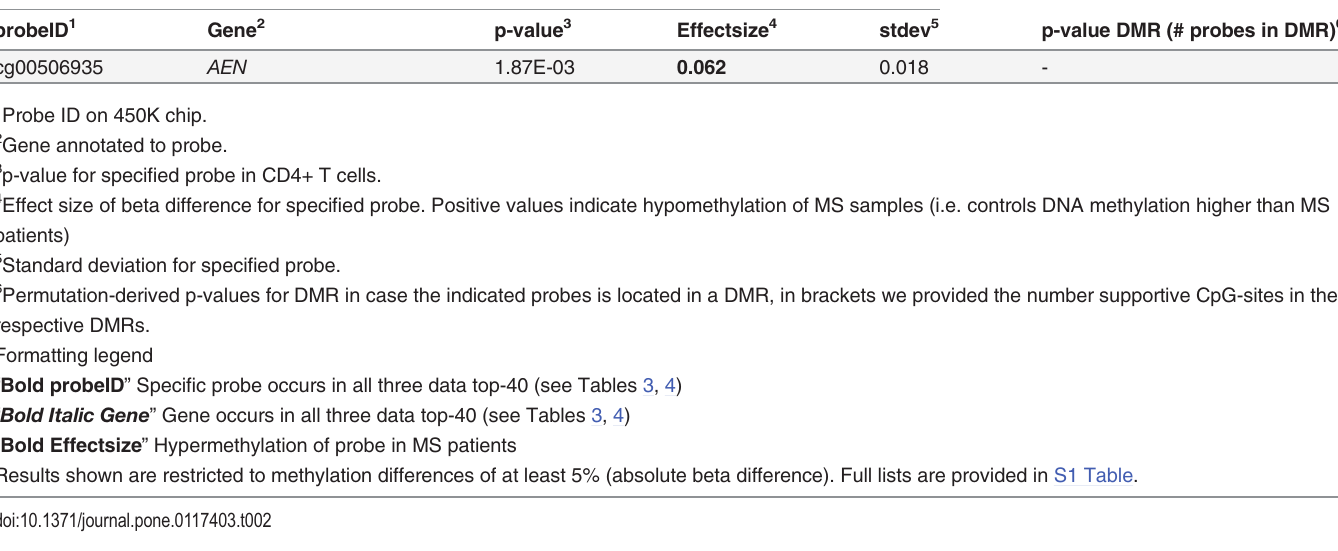
(Fig. 2B). For blood and CD4+ T cells, the distributions of hyper vs. hypomethylated CpG-sites were nearly identical (~50%) and not significantly different (Fig.